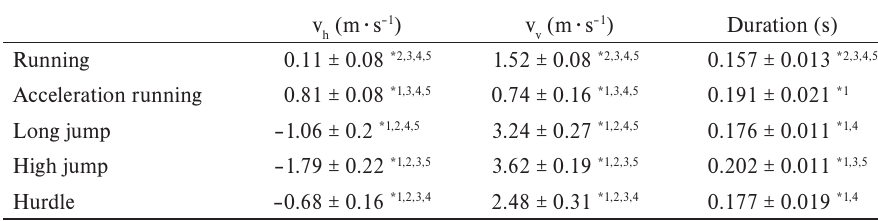
Changes of velocity and duration during take-off